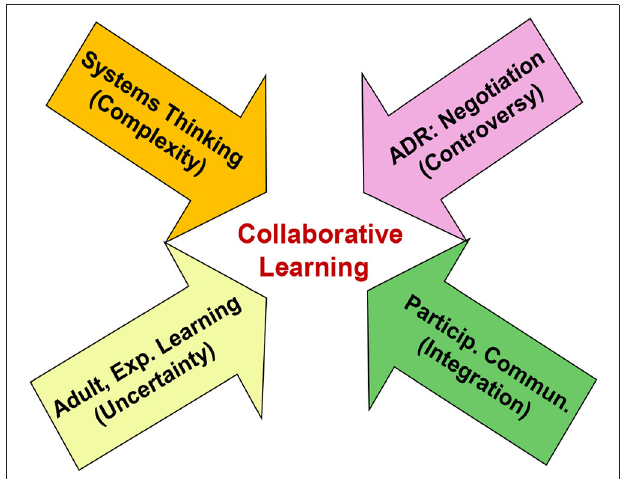
FIGURE 1 | Collaborative learning foundations. Daniels and Walker